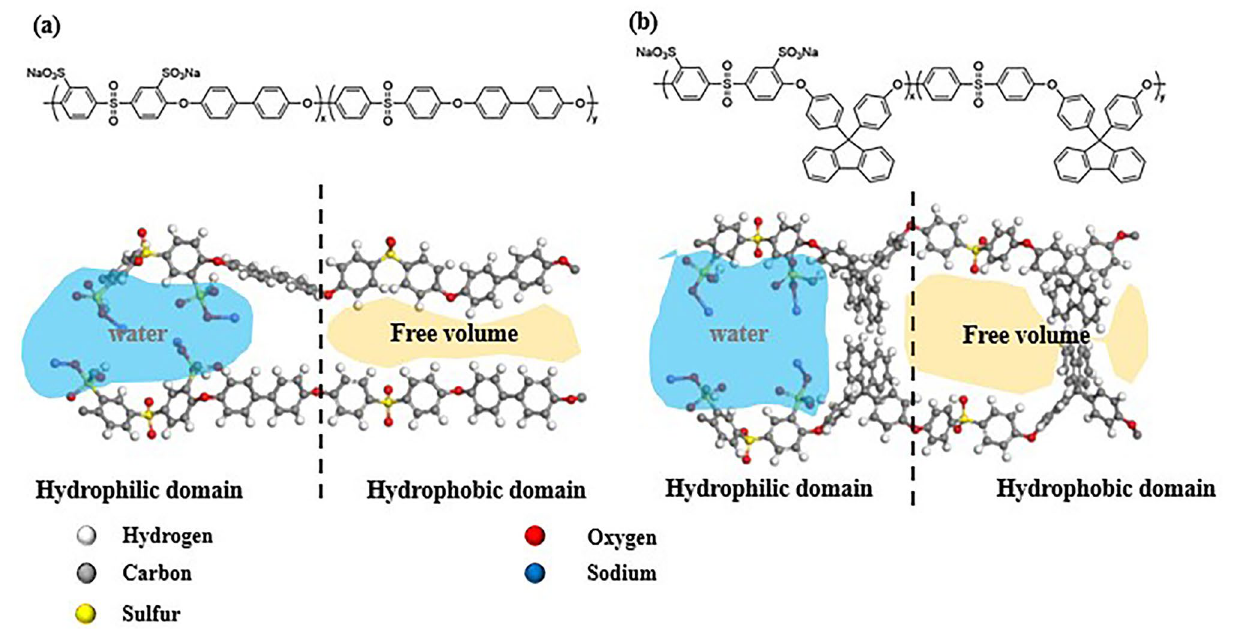
Figure 1. Chemical structures of the ( a ) BP-SPES composed of a flat linear structure and ( b ) FL-SPES composed of a steric structure.